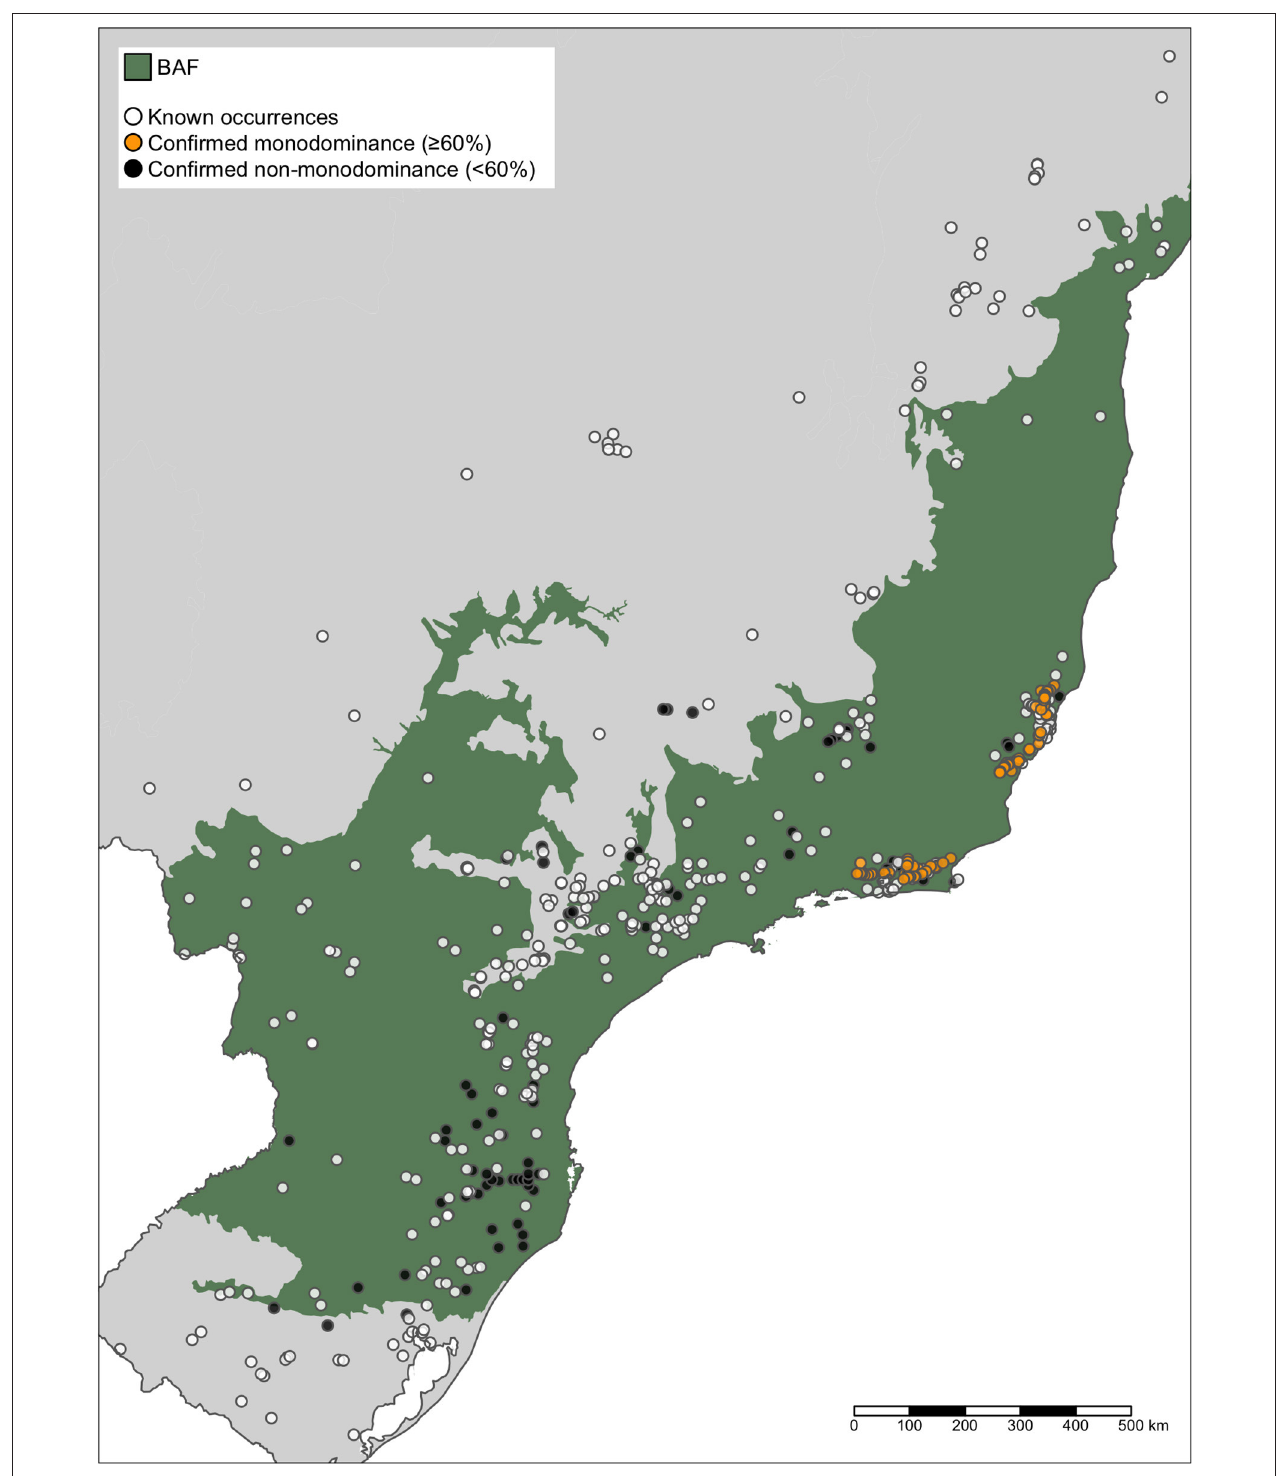
FIGURE 6 | Occurrence records for Moquiniastrum polymorphum along its whole area of distribution. We visited the areas with symbols in black and orange. Orange symbols indicate sites where the species was present as a monodominant (more than 60% relative abundance) and black symbols indicate sites where the species was present but not monodominant. The shaded green area corresponds to the official limits of the Brazilian Atlantic Forest (BAF; IBGE, 2019).